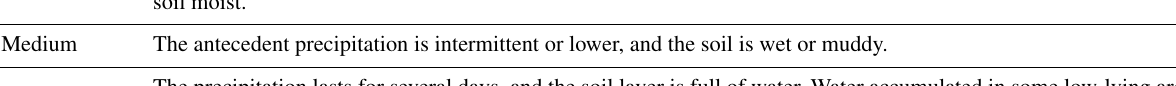
Table 1. Qualitative grading criteria of antecedent precipitation. Classification Standard of classification